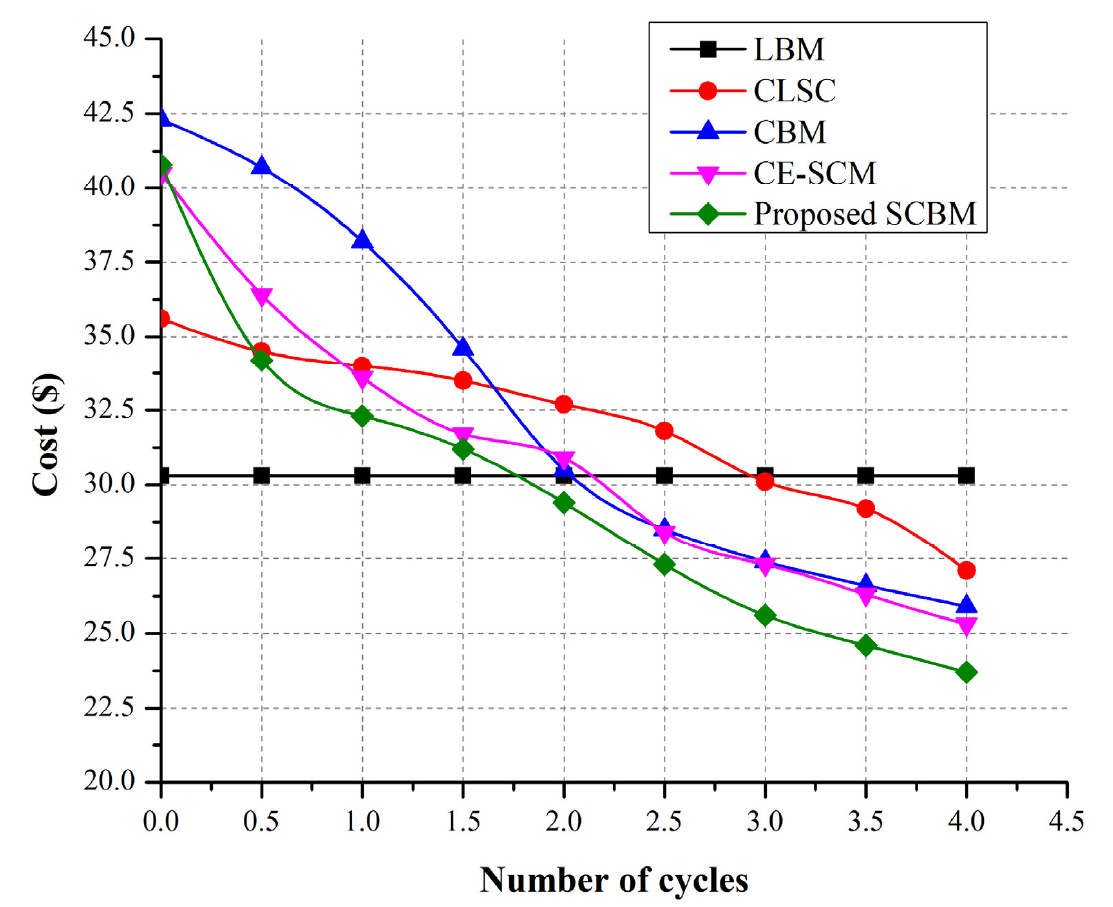
Figure 7. Cost analysis as a function of reuse cycles for different business models.